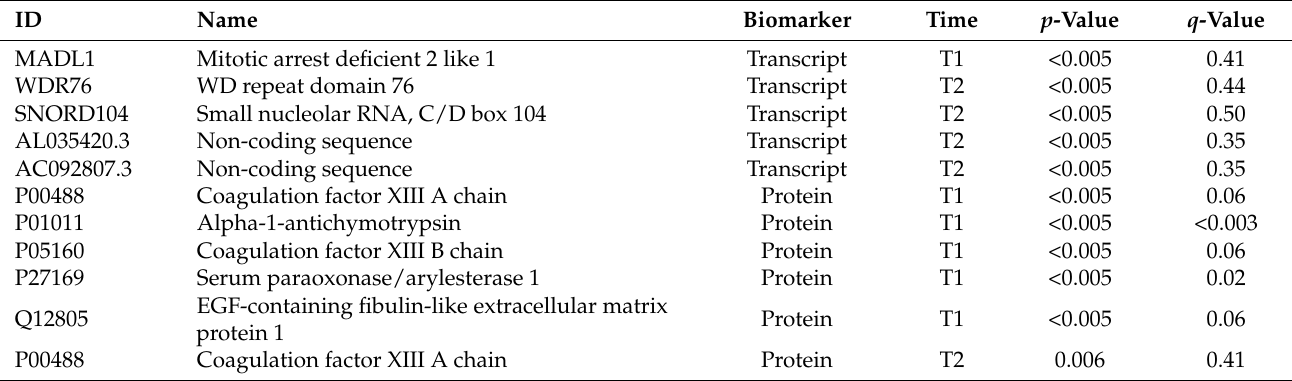
Table 3. One-way ANOVA for the biomarkers related to myocardial injury in the whole cohort (MI: n T1 = 20 and n T2 = 19— no MI: n T1 = 7 and n T2 =